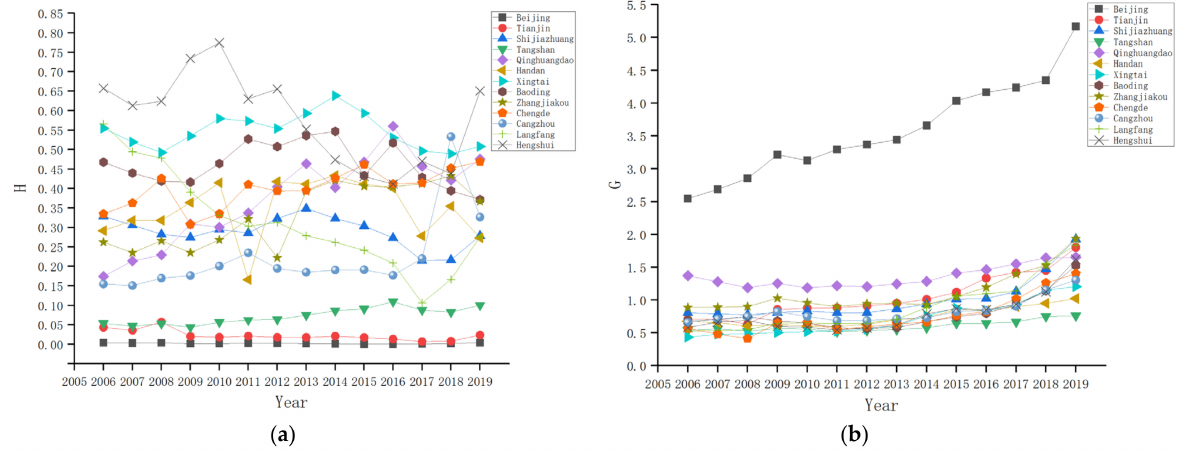
Figure 4. ( a ) The rationalization index of industrial structure in each city; ( b ) the upgrading index of industrial structure in each